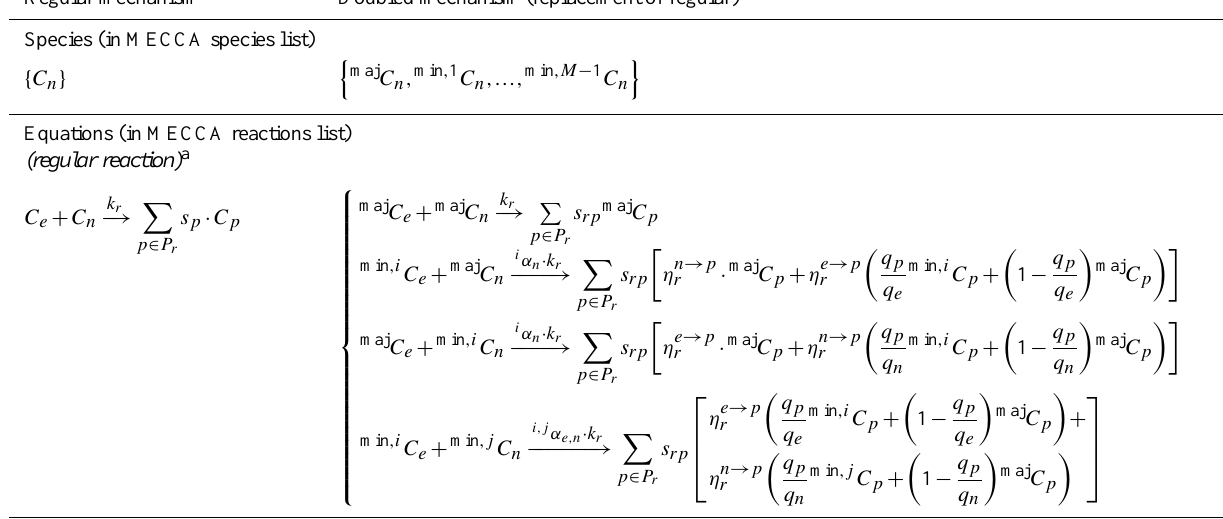
Table 1b. Example for explicit isotopic doubling of the regular chemical mechanism. Regular mechanism